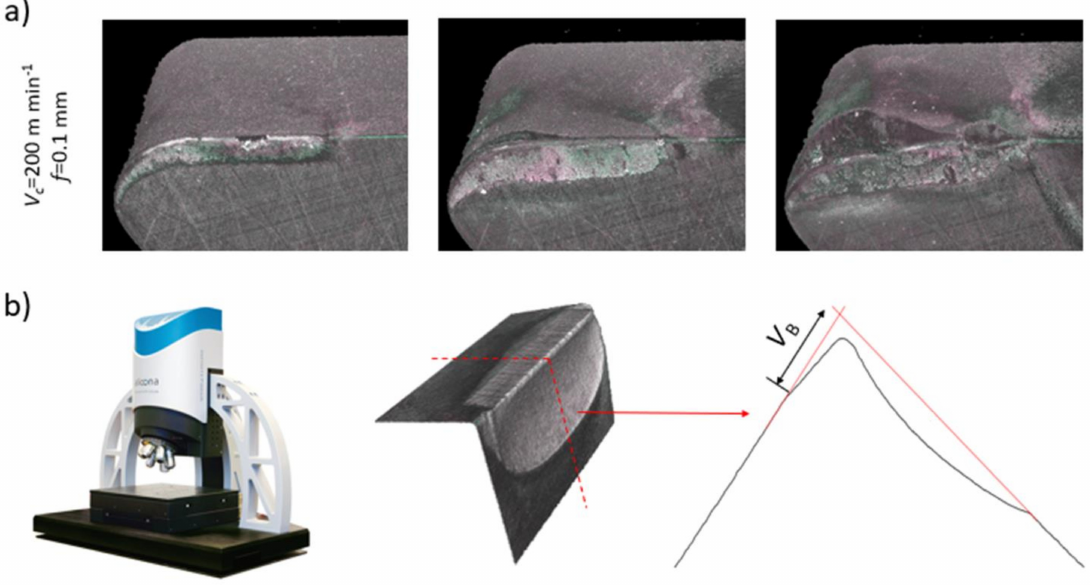
Figure 7. Wear measurement strategy with Alicona Infinite Focus G4: ( a ) 3D topology of worn tool and ( b ) extracted 2D profile of worn